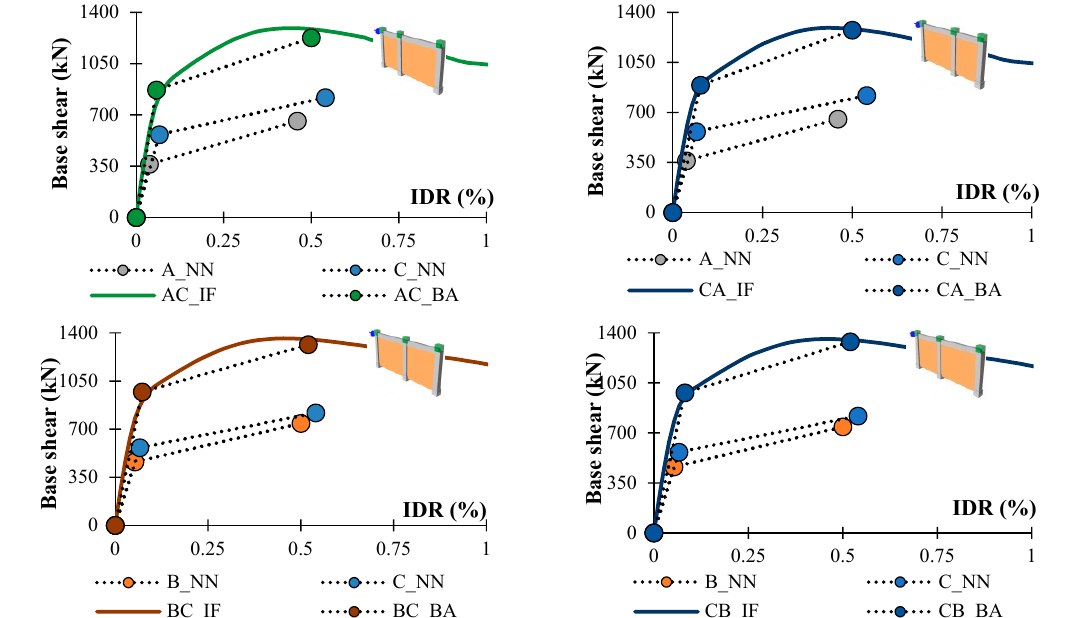
Figure 10. Capacity curves for multi-bay frames with different bay length.